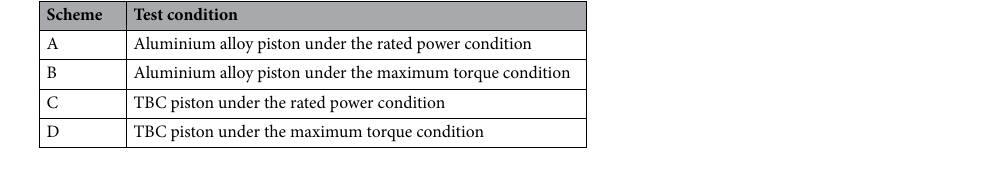
Table 3. Test and test conditions.